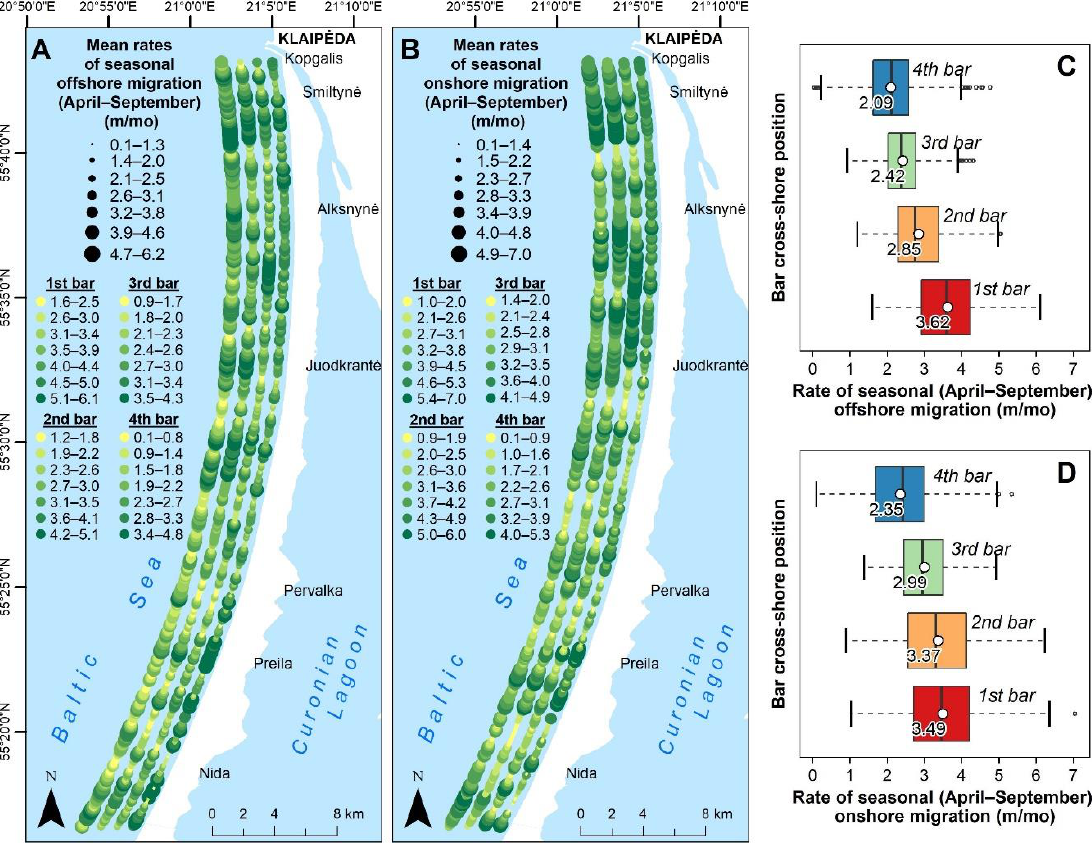
Figure 7. Alongshore variability in rates (m/month) of seasonal offshore ( A ) and onshore ( B ) migra- tion in April – September. The colour scale indicates seasonal migration rates in April − September for different bar cross-shore positions (1st to 4th bar). It is set separately for each position and explained by the legend below the underlines. The 1st bar is depicted furthest from the shore and the 4th bar − closest. Boxplots illustrate the statistical distribution of the seasonal offshore ( C ) and onshore ( D ) migration rates by the cross-shore position of the bars.